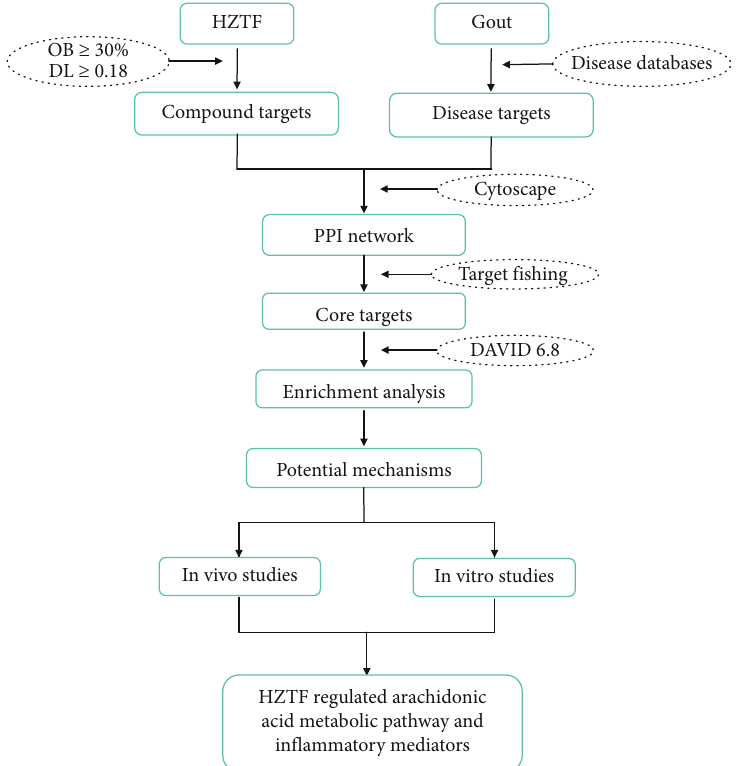
Figure 1: Flowchart of study design — based on an integration strategy of network pharmacology and experimental